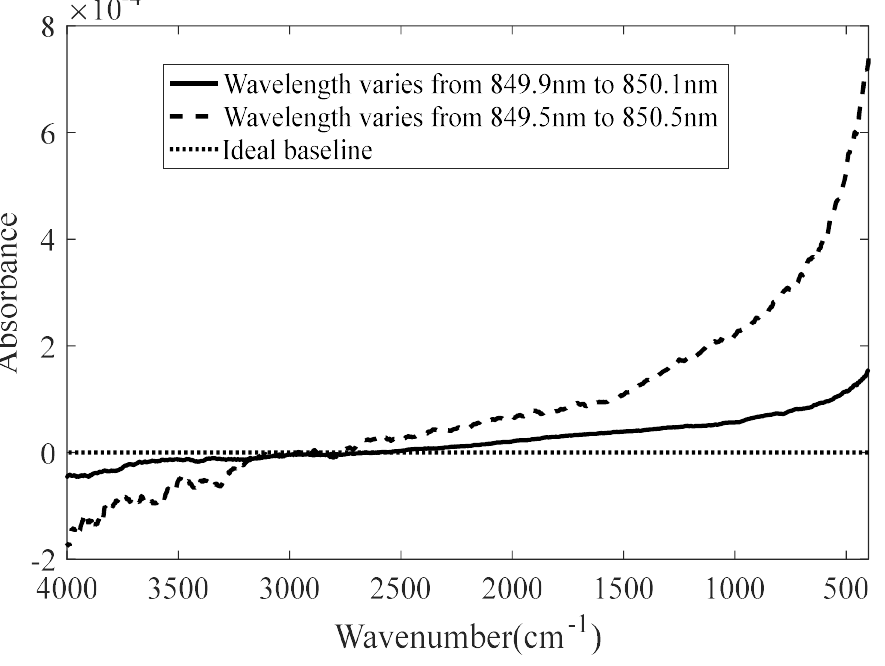
Figure 8. The baseline varies with respect to the laser wavelength.